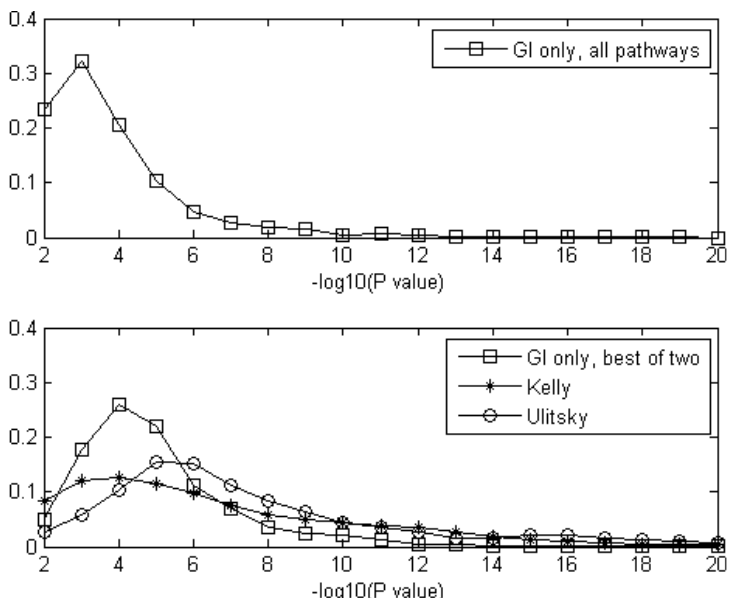
Figure 5. The distribution of the number of identified pathways as a function of the functional homogeneity. Upper panel: the functional homogeneity of all the pathways from each pathway pair identified by our method. Although a considerable percentage of pathways identified by our method had high homogeneity scores, many of them showed a low functional homogeneity due to multifunction effects. Bottom panel: at least one of the two pathways of each pathway pair identified by our method had high homogeneity. Note that the functional homogeneity score was still significantly lower than that of the pathways identified using physical interaction data.